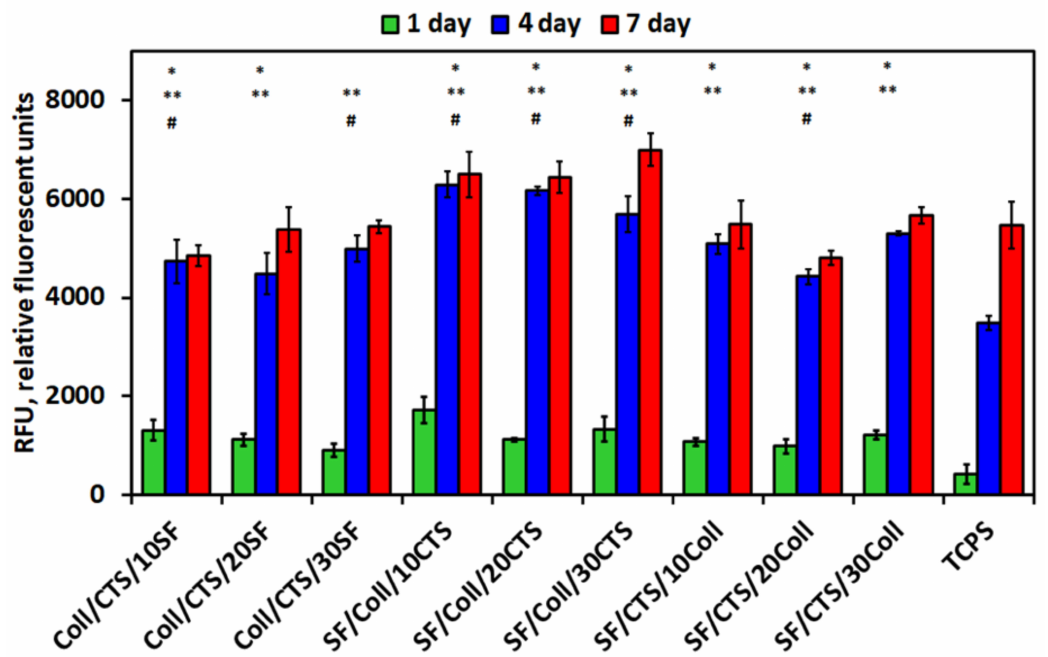
Figure 13. Metabolic activity after 1, 4 and 7 days of MG-63 cells cultured on studied scaffolds (n = 3, mean ± SD; p ≤ 0.05; *—significantly different between sample and TCPS in 1 day; **—significantly different between sample and TCPS in 4 days; #—significantly different between sample and TCPS in 7